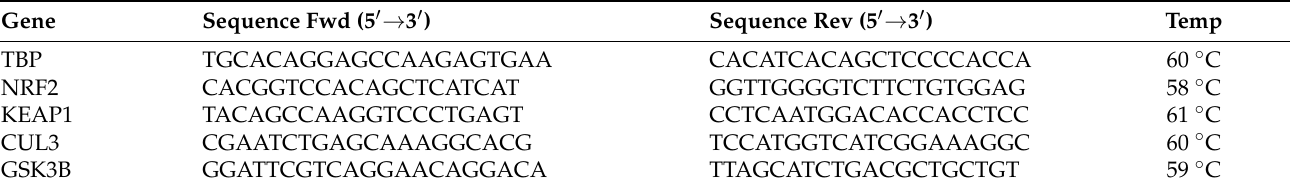
Table 2. Primer sequences used in RT-qPCR and temperature